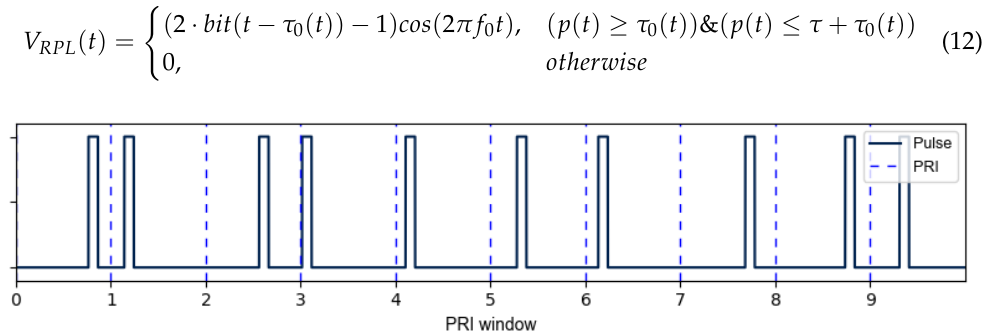
Figure 1. Sample RPL gate function activation delays τ 0 ( t ) to achieve a random